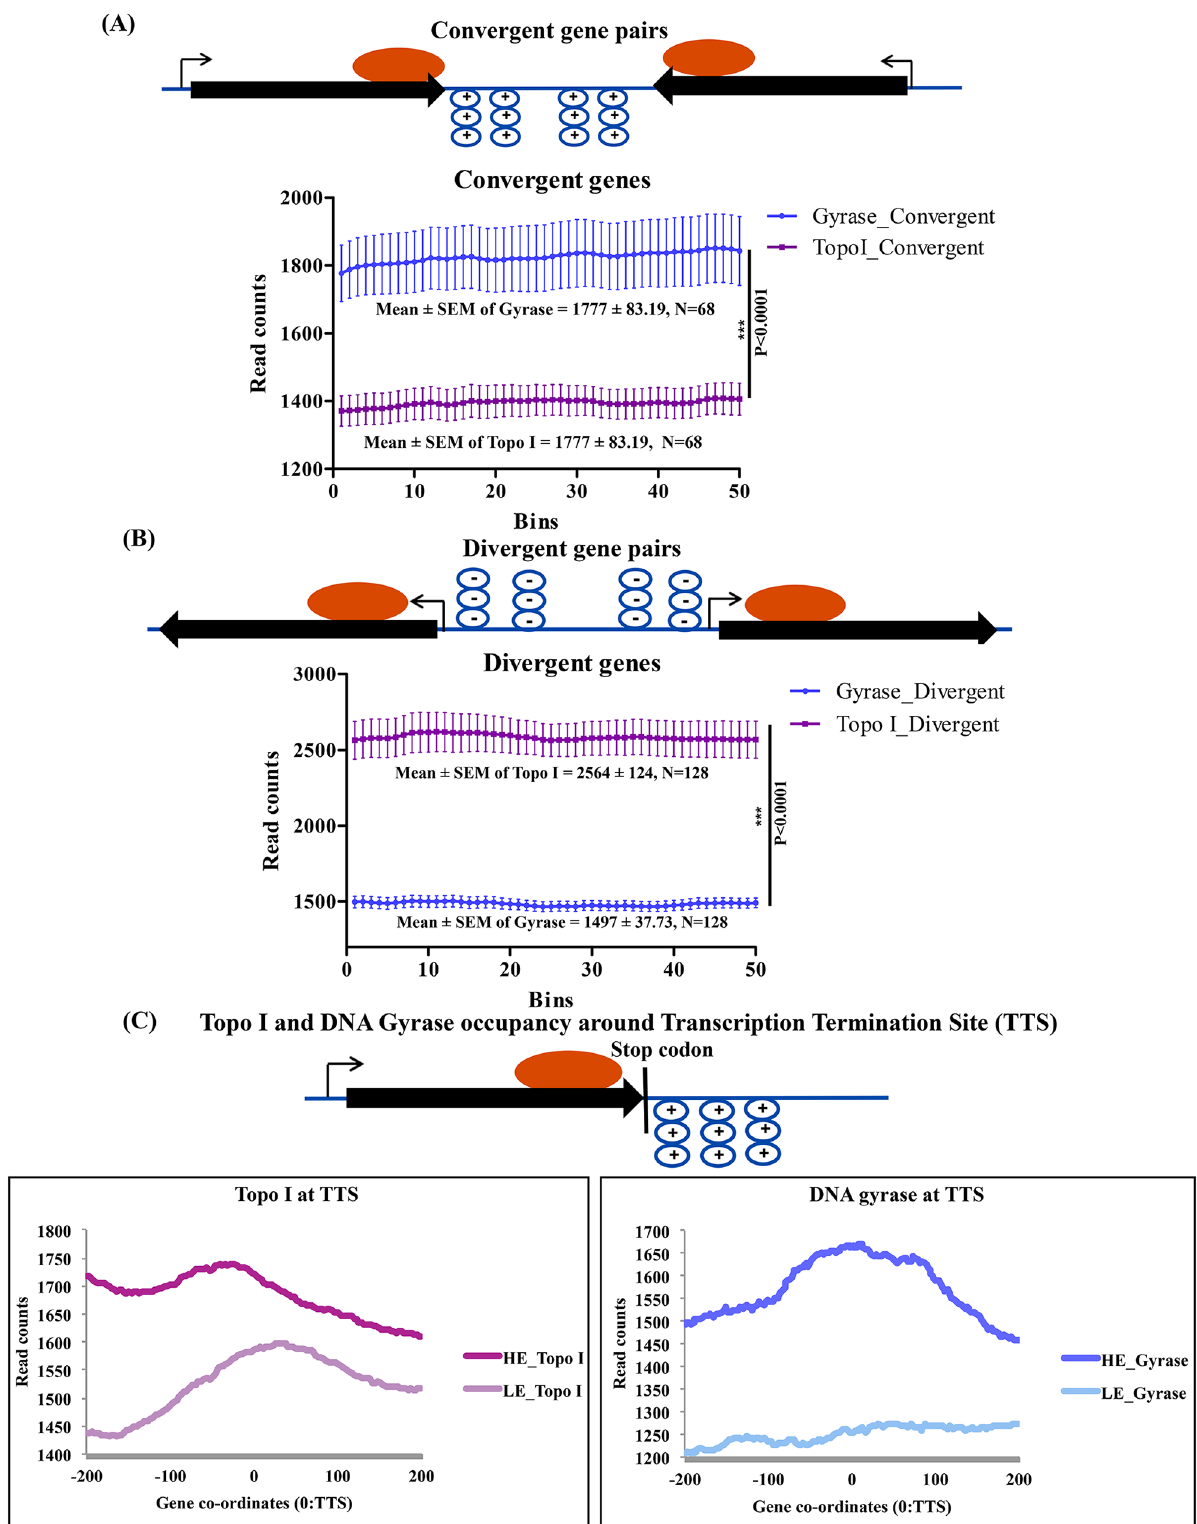
Fig 5. Transcription induced supercoils recruit topoisomerases. (A) and (B) Occupancy of topoisomerases on convergent and divergent genes respectively. The convergent (N = 68) and divergent(N = 128) genepairs were extracted (from NCBI) and the intergenic